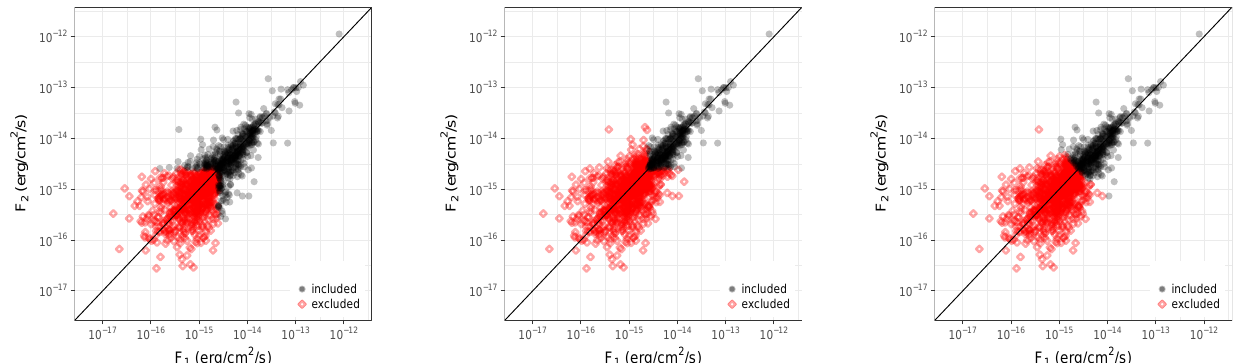
Fig. 3.— Illustration of sample definitions and resulting biases. The points show the measured fluxes in each observation for the full sample, excluding error bars and upper limits for clarity. Filled circles indicate points included by a given sample definition while hollow diamonds indicate excluded points. The left panel illustrates a selection where ( F 1 OR F 2 ) > 2 . 5 × 10 − 15 erg s − 1 cm − 2 , which biases the measured σ high. The centre panel illustrates a selection where ( F 1 AND F 2 ) > 2 . 5 × 10 − 15 erg s − 1 cm − 2 (biasing the measured σ low).